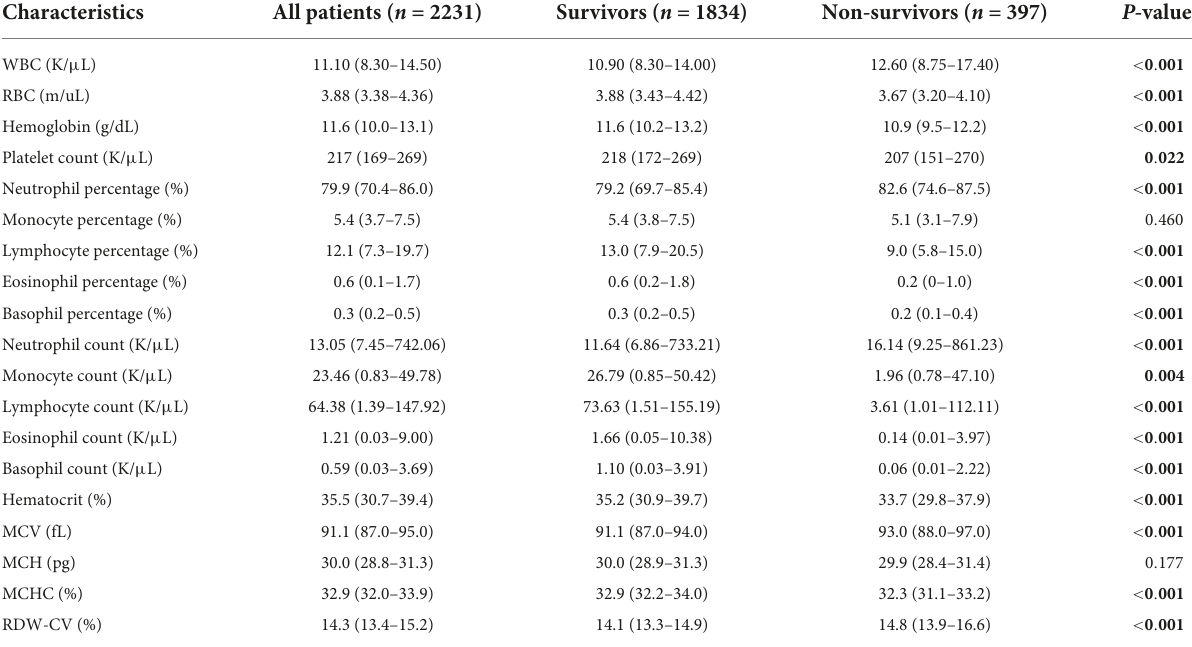
TABLE 3 Comparison of baseline complete blood count with differential characteristics between survivors and non-survivors in the included cohort.